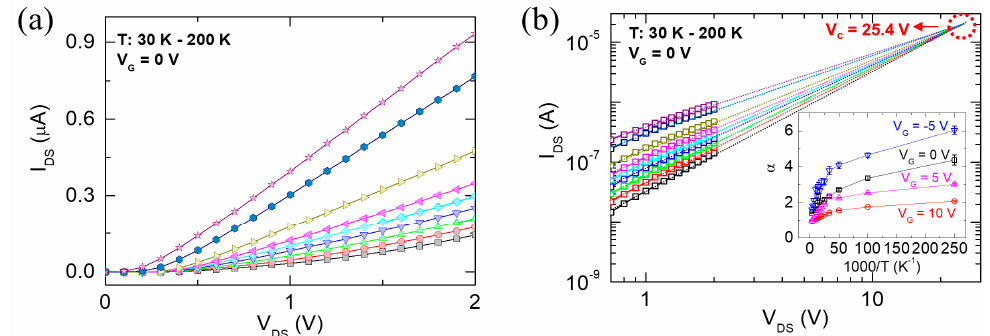
Figure 3. ( a ) I DS -V DS curves measured at V G = 0 V and different temperatures (30–200 K) for the ZnO nanowire FET; ( b ) The extrapolation derived from the corresponding logscale I DS -V DS characteristics at different temperatures of ( a ), which provide a critical voltage ( V C ).